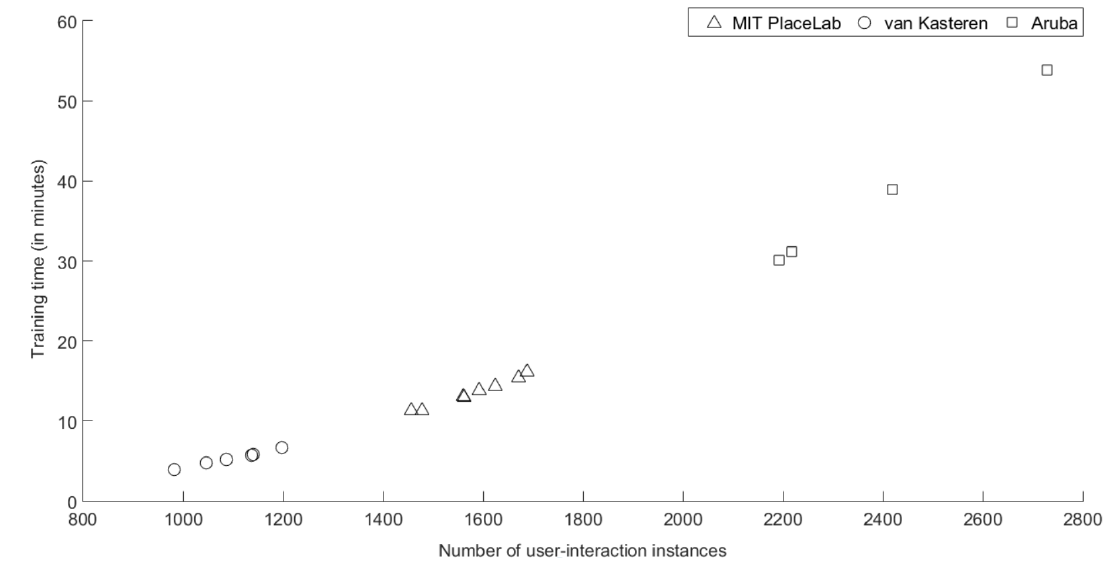
Figure 5. Training time (in minutes) across the number of user-interaction instances on three datasets (MIT PlaceLab, van Kasteren and